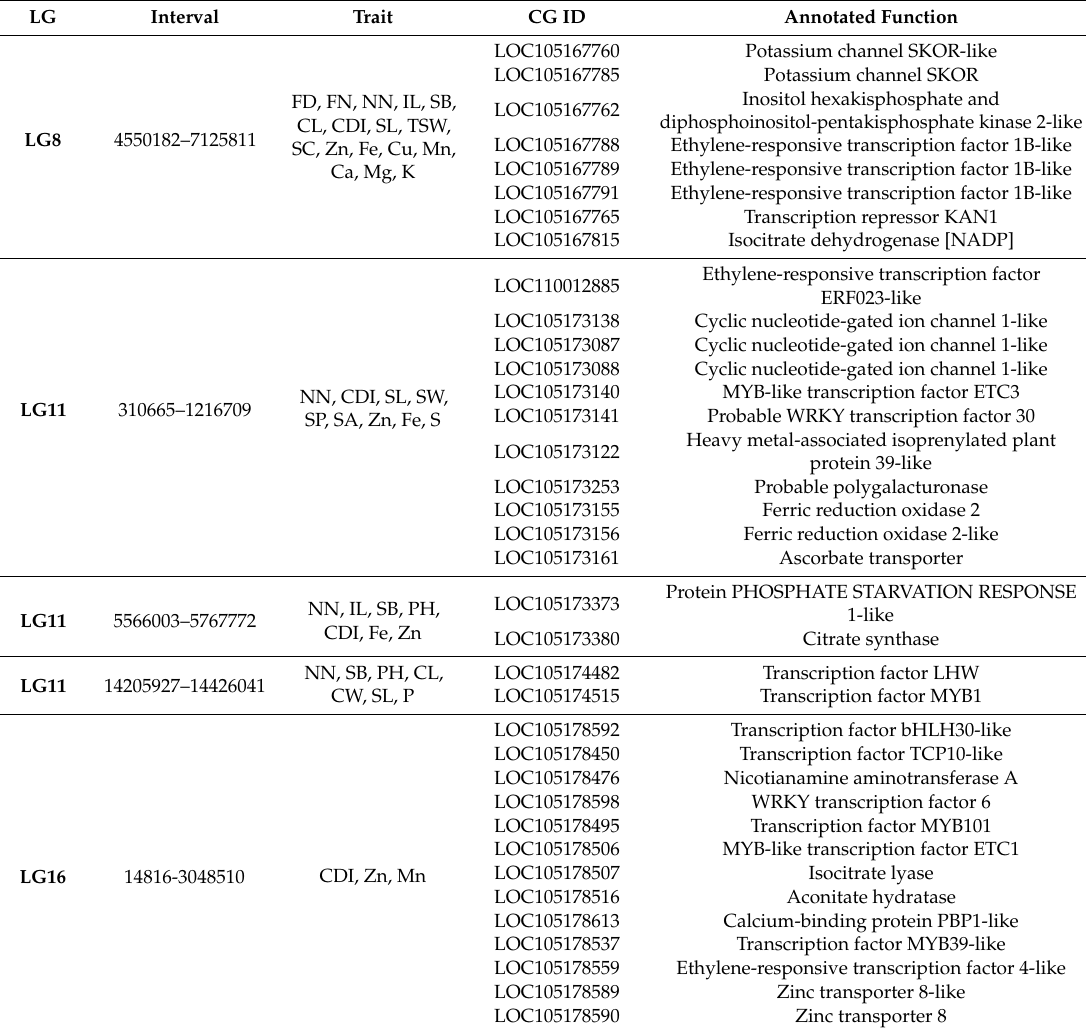
Table 3. A list of candidate genes residing within the hotspot of multi-traits QTL